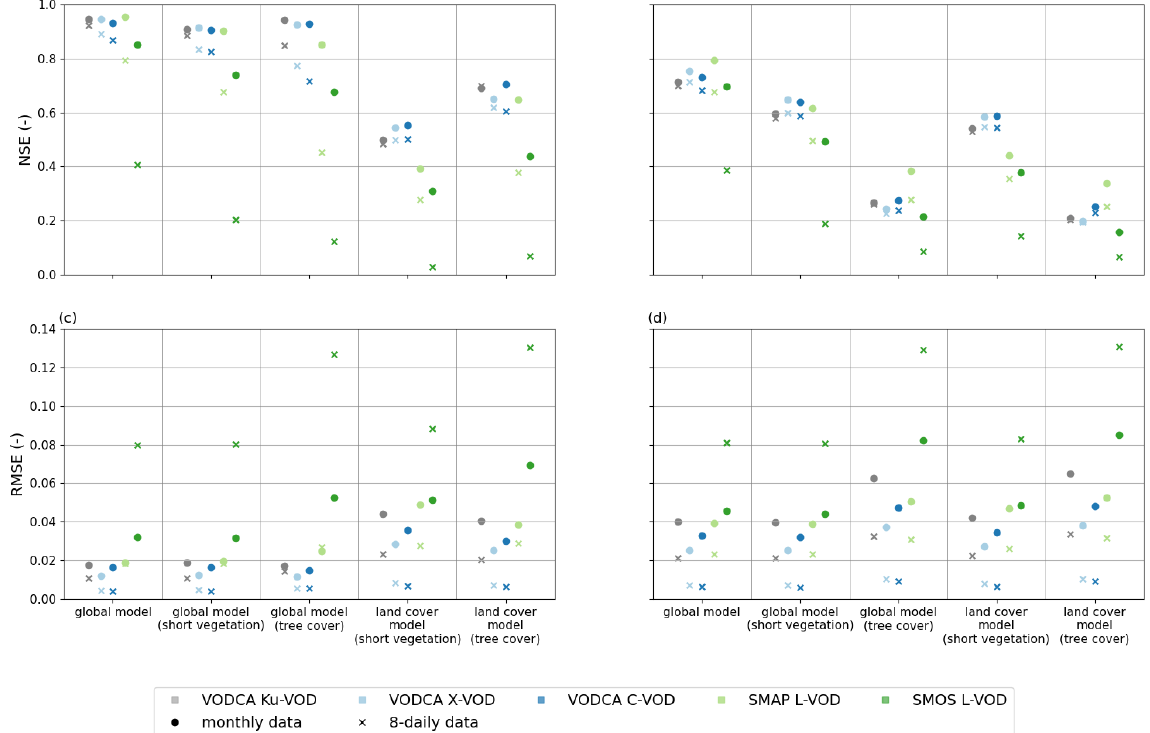
Figure 2. Nash–Sutcliffe model efficiency coefficient (NSE; a, b ) and RMSE (c, d) of random forest models (RF; a, c ) and generalized additive models (GAM; b, d ) using monthly (circle) or 8-daily (crosses) data. The global model uses PFTs as predictors, contrary to the land cover models, which were calibrated and applied only to the spatial extent of a certain dominant land cover class. Global model for short vegetation and tree cover show results of the global model but filtered by dominant land cover